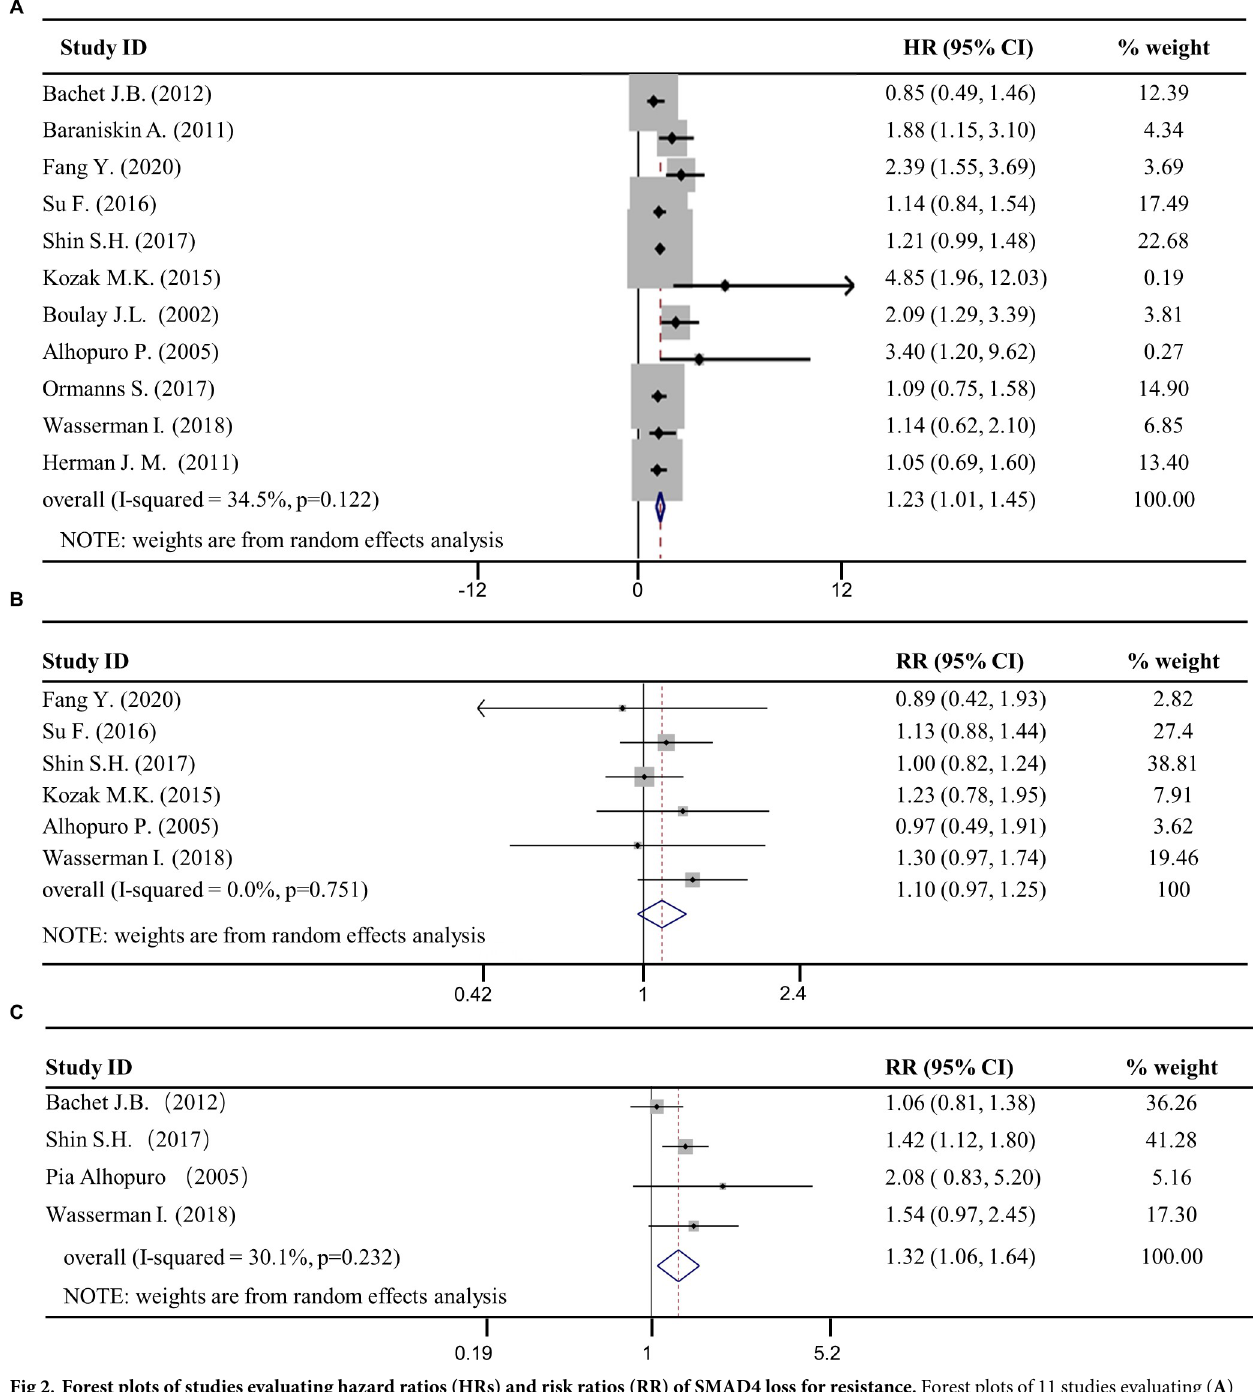
PLOS ONE | https://doi.org/10.1371/journal.pone.0250634 May 28, 2021 7 /